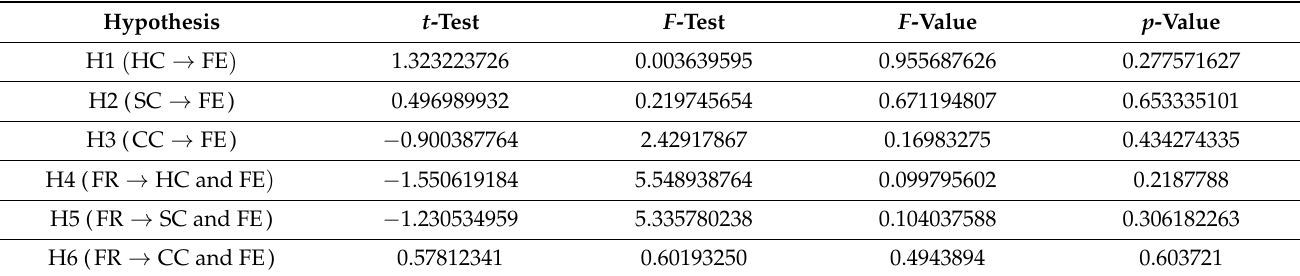
Table 8. Results of the hypotheses